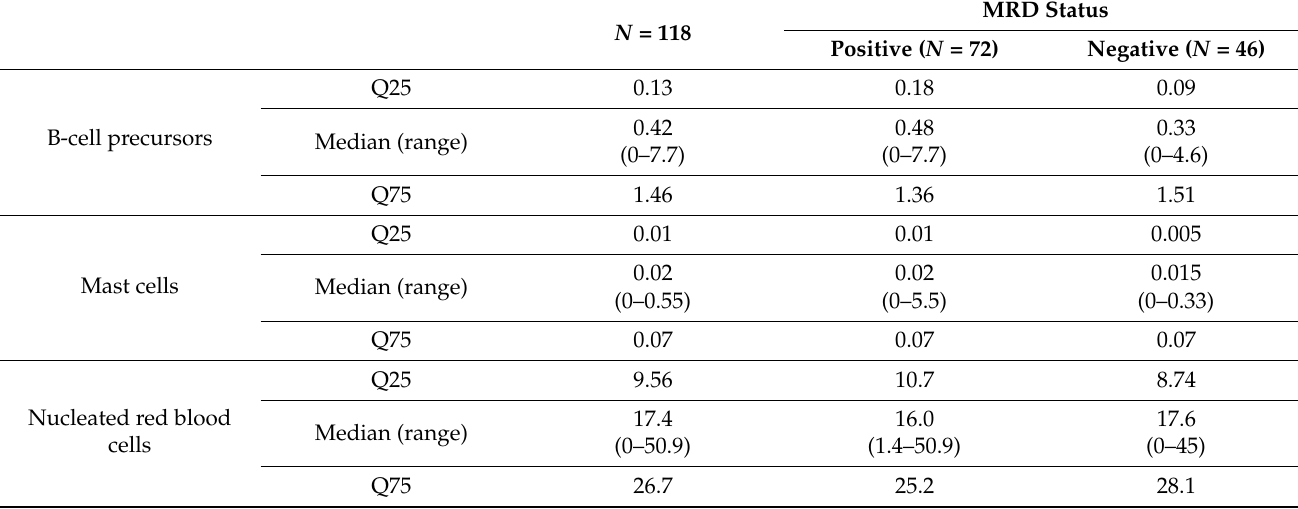
Table 2. Median (range) and quartile percentages of B-cell precursors, mast cells and nucleated red blood cells in bone marrow aspirates of patients with multiple myeloma enrolled in PETHEMA/GEM2010MENOS65. Patients were grouped according to their MRD status at the end of the